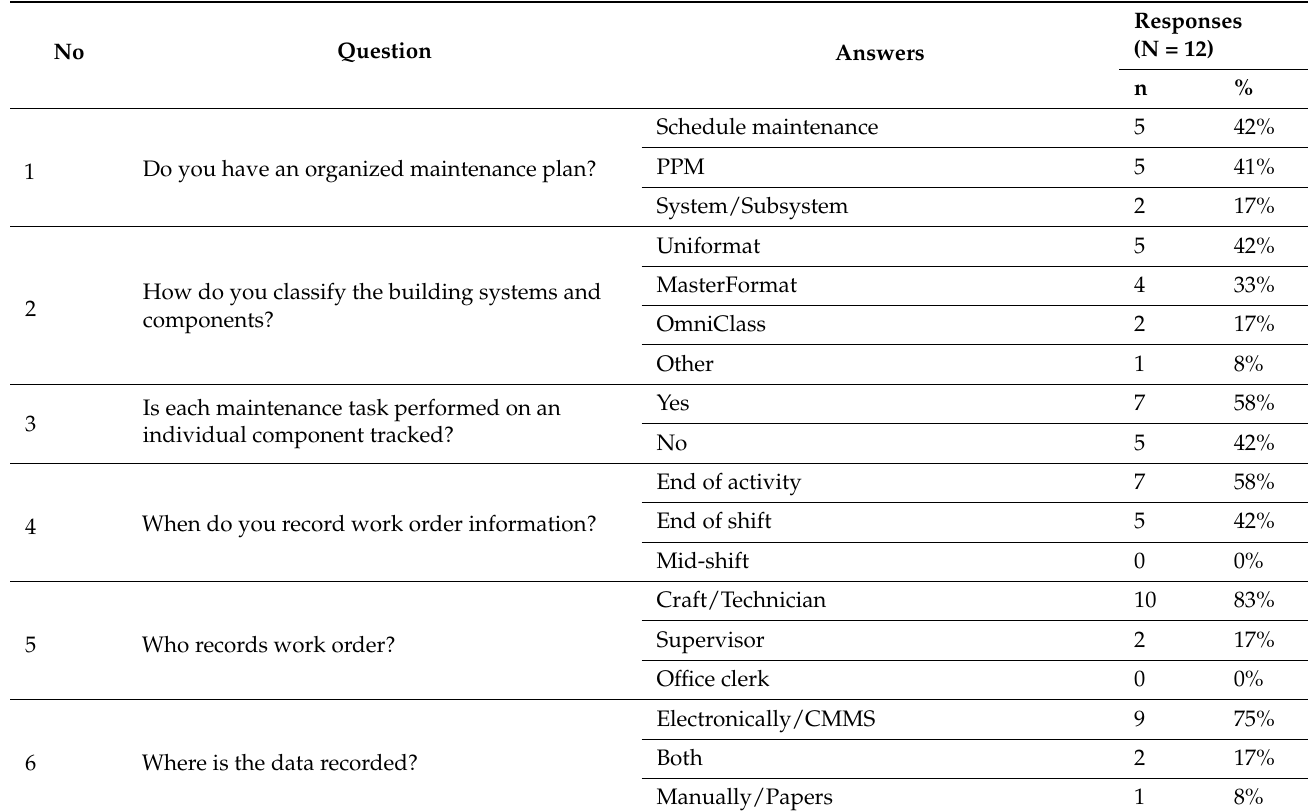
Table 3. Phone interview